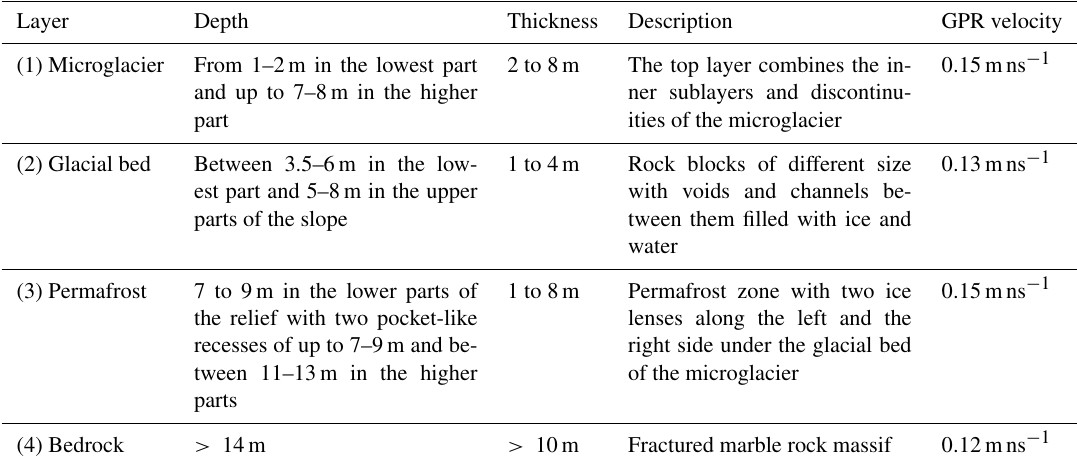
Table 2. Description of the stratigraphy of the studied area.